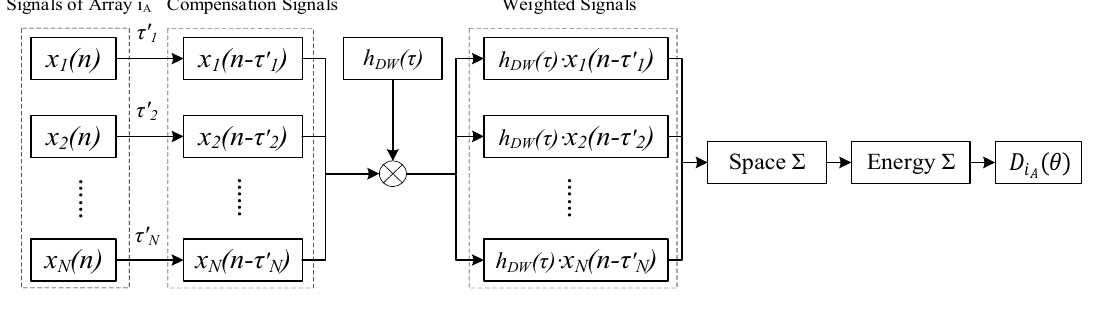
Figure 3. Weighted beamforming.